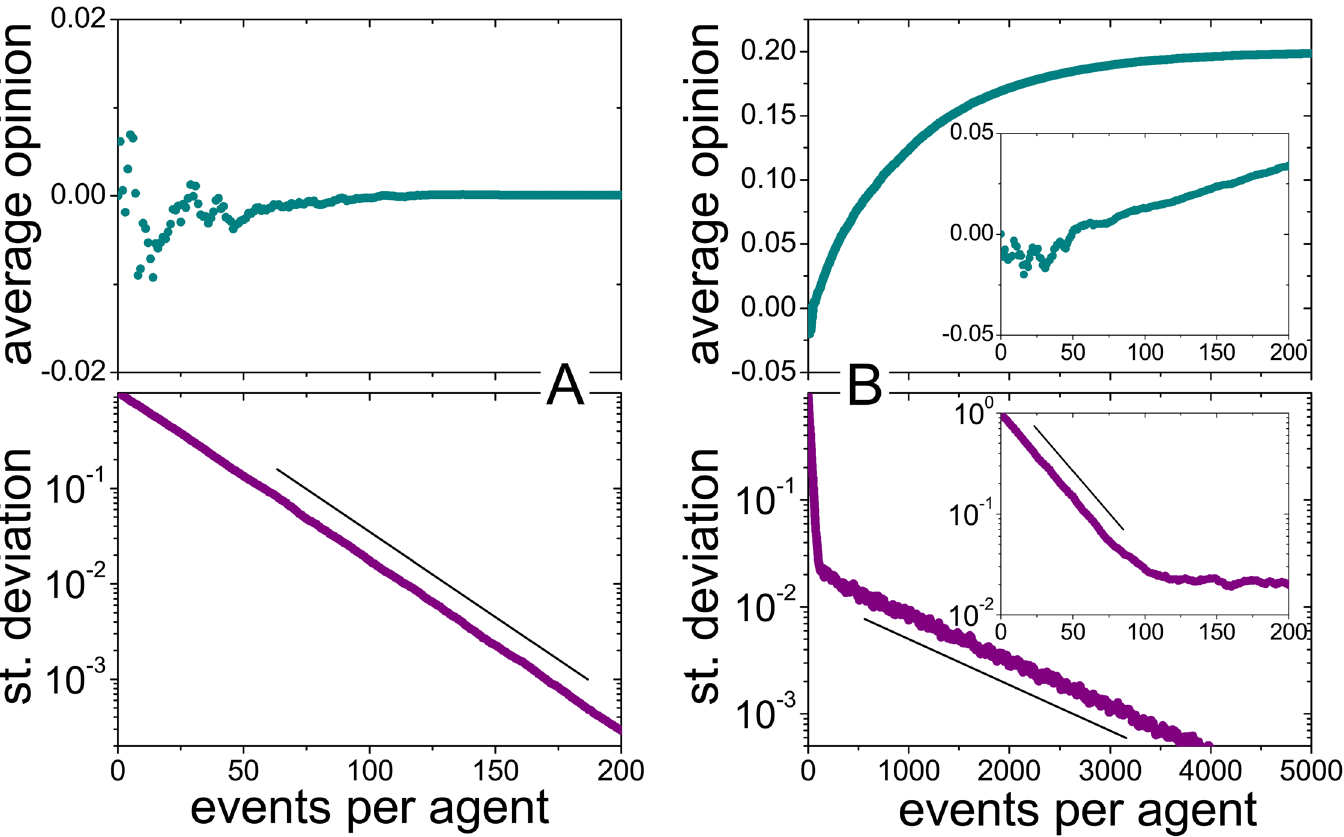
Fig 4. Evolution of the average opinion and the standard deviation. The plots show simulation results for a population of 10 4 agents, whose initial opinions where normally distributed and whose confidence is distributed as observed in the first round of the experiment. Results are plotted as functions of the number of events per agent. Straight lines stand for the analytical prediction of exponential slopes (see S3 Text). A: Without opinion leaders. B: With one opinion leader, whose opinion is R = 0.2. The leader ’ s influence factor is distributed as for any ordinary agent, but the leader is chosen as a reference 100 times more often than any other agent. The insets are close-ups of the initial evolution